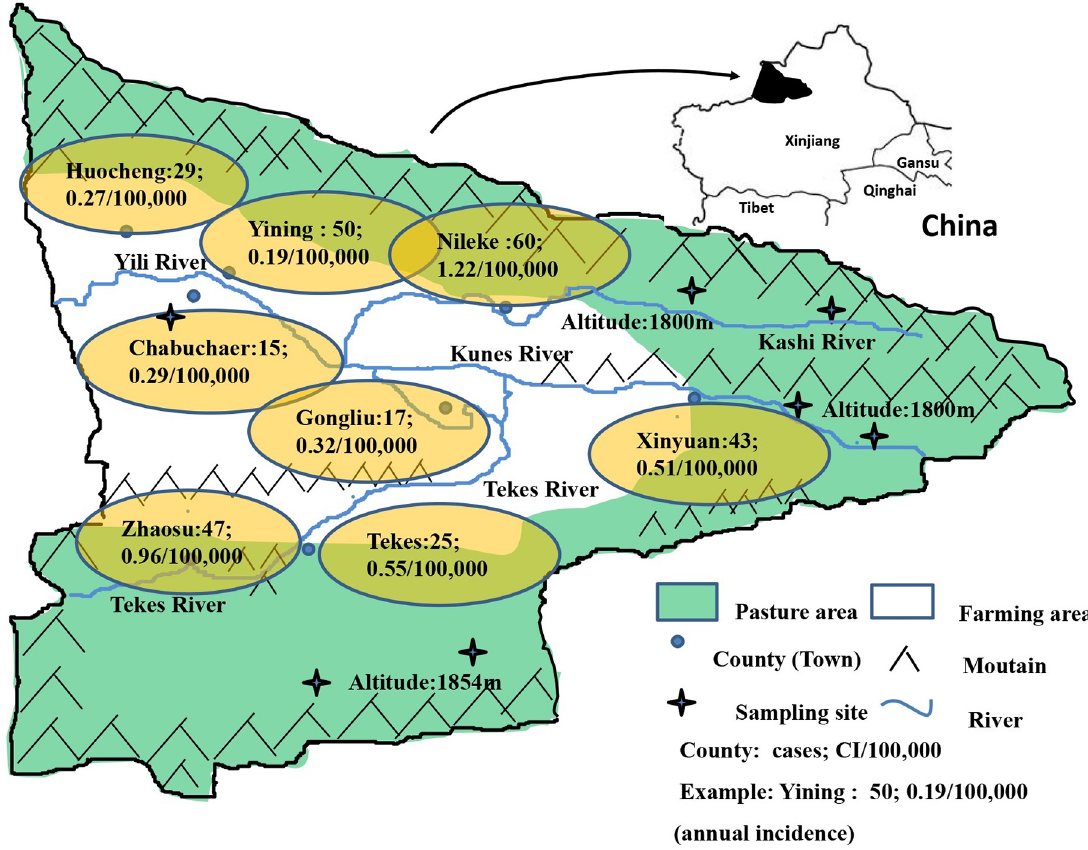
Fig 1. Distribution of alveolar echinococcosis cases in Yili Prefecture, Xinjiang. In the figure, “green” indicates grassland, “white” indicates agricultural land, “yellow” indicates the city name and location, “cross” indicates the sampling site, and “blue curve” indicates a river. Cumulative incidences in each of the counties are also